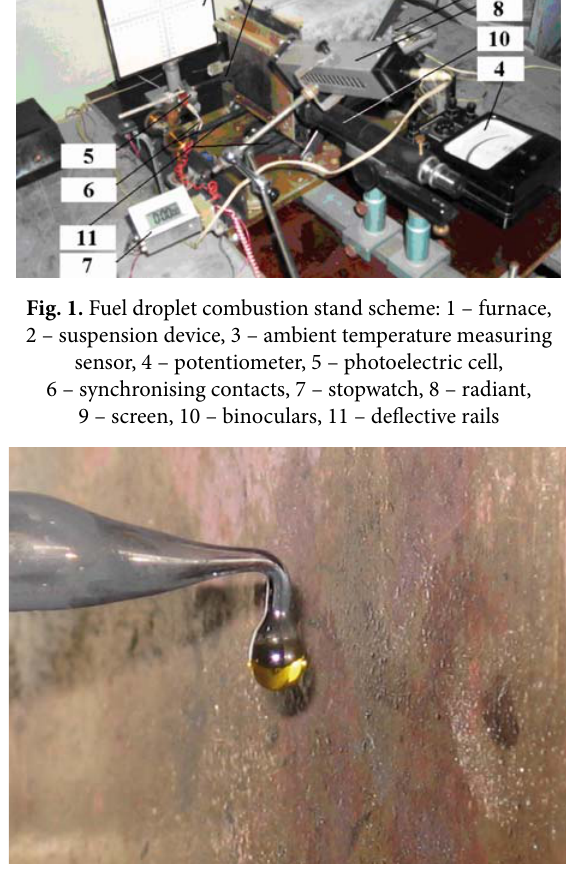
Fig. 2. Fuel droplet hanging on the suspension